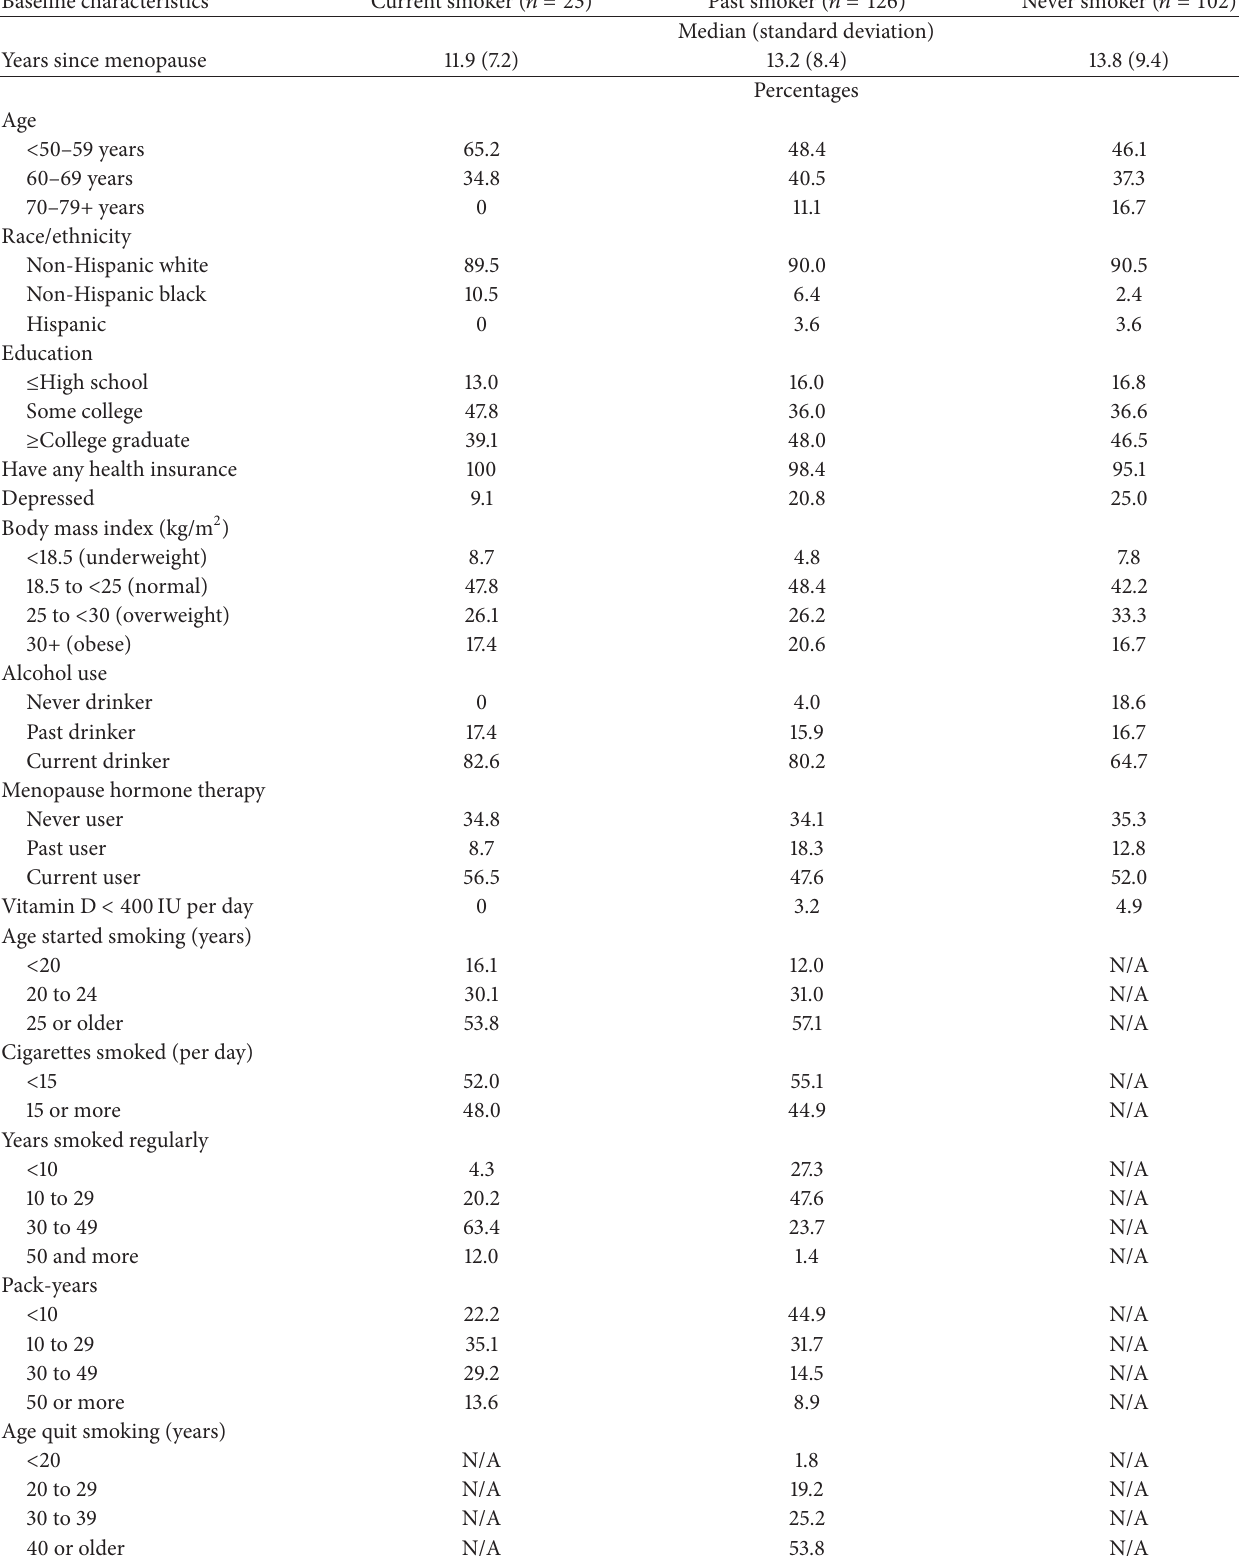
Table 1: Baseline characteristics of postmenopausal women with multiple sclerosis by smoking status in the Women’s Health Initiative Observational